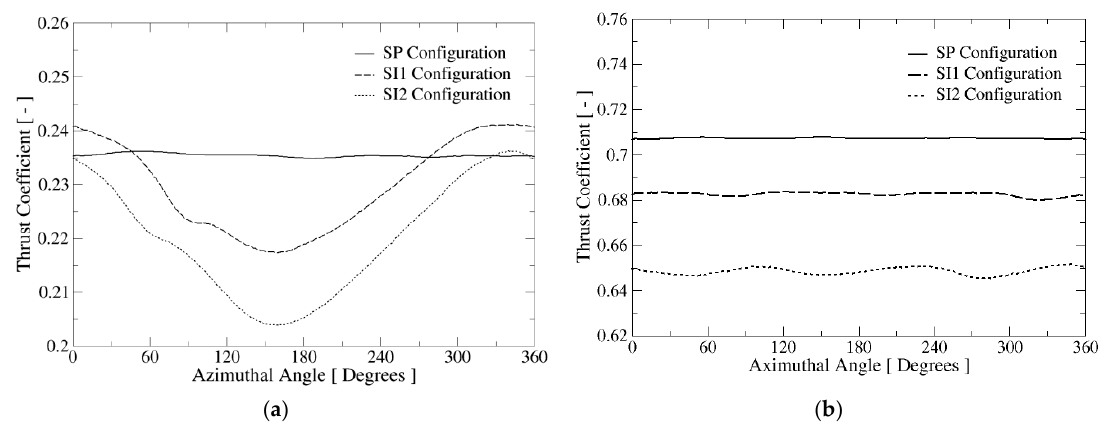
Figure 6. The thrust coefficient at λ = 5.7 for the three studied configurations, SP, SI15 (15°) and SI30 (30°) inclined with respect to the flow direction: ( a ) one blade; ( b ) complete turbine.